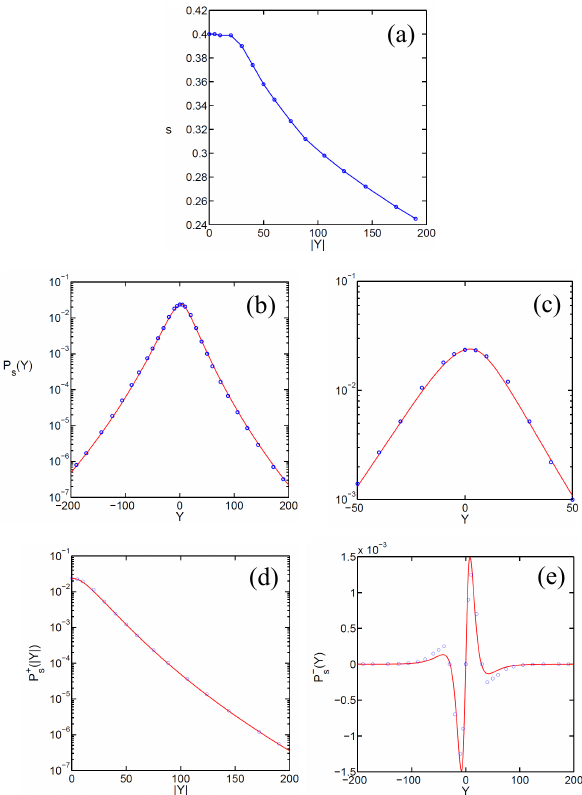
Fig. 5. ROMA spectrum s(Y ) and scaled PDF function P s (Y) for the fluctuations of longitudinal velocities in JHU database. (a) s(Y ), which is symmetric with respect to Y = 0, shows monofractal be- havior at | Y | < 25 and decreases monotonically at larger | Y | . (b– c) P s (Y) , which is asymmetric about Y = 0. (d–e) P + (Y) and P − (Y) of P s (Y) , similarly defined as in Eq. (1). In (b–e) , open circles show P s (Y) ; solid red curves show a fit with a modified Castaing form of Eq. (3) with X replaced by Y , with σ 0 = 18 . 25, Y 0 = 2 . 55, λ = 0 . 425, a s = 0 . 4.